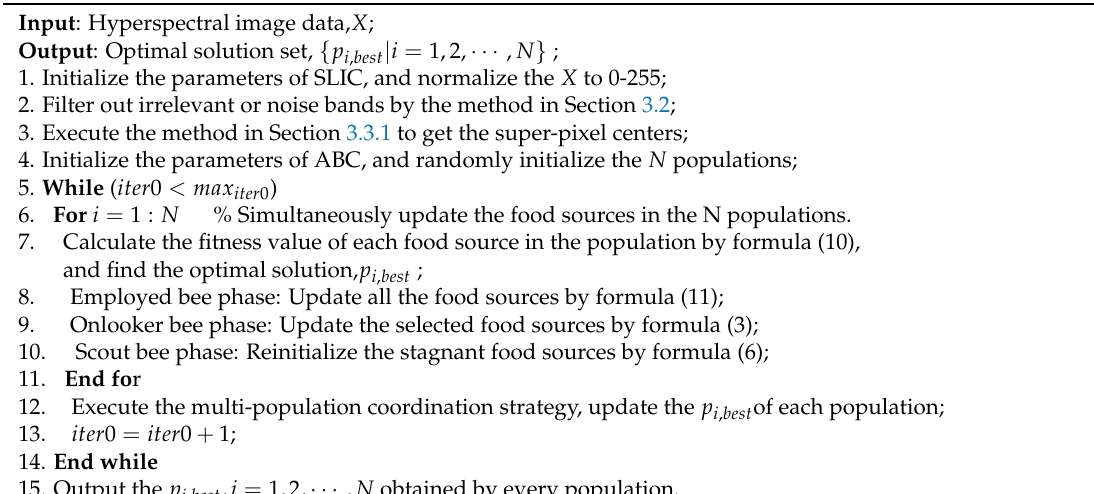
Algorithm 1: The proposed hypergraph evolutionary clustering based on ABC,